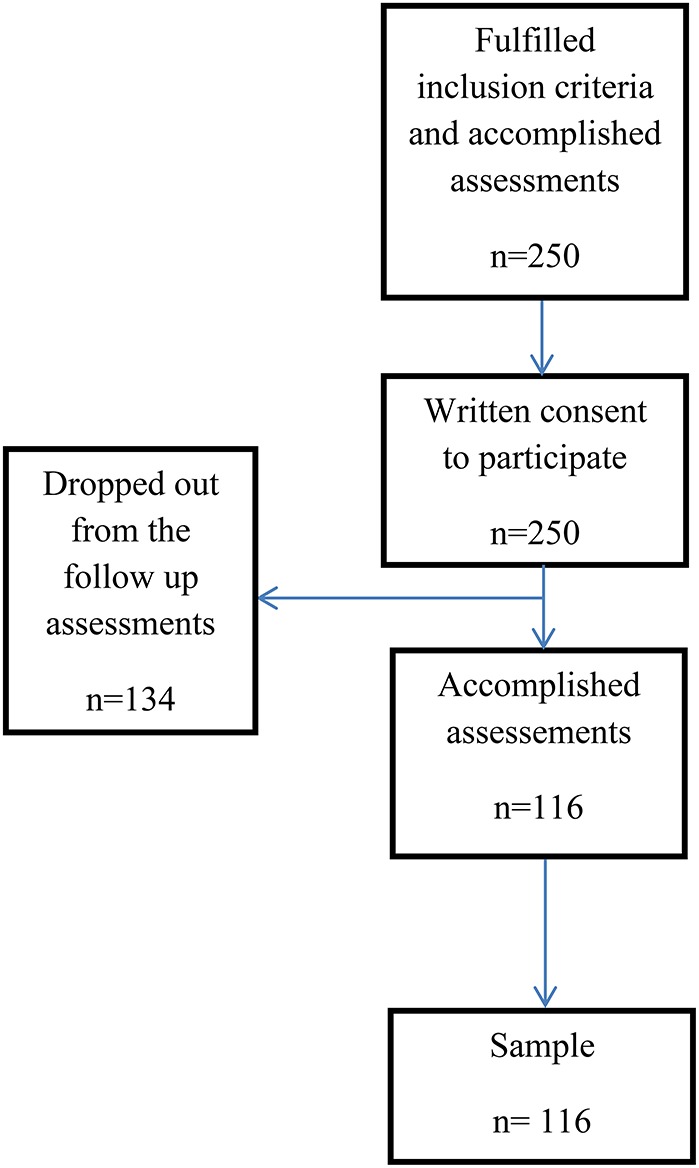
Sample recruitment.